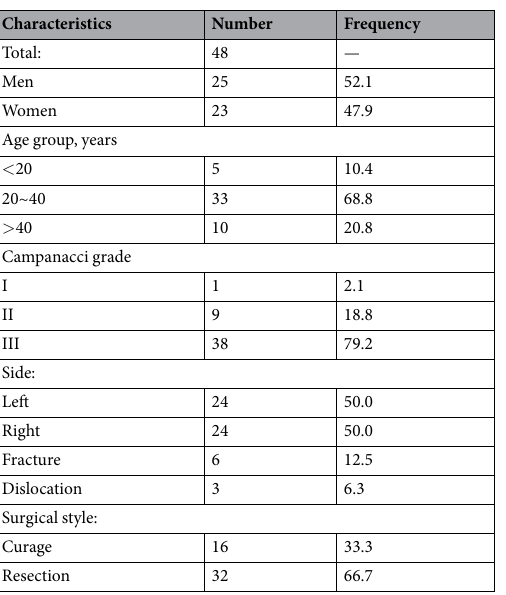
Table 1. The distribution characteristics of primary GCT of distal radius in